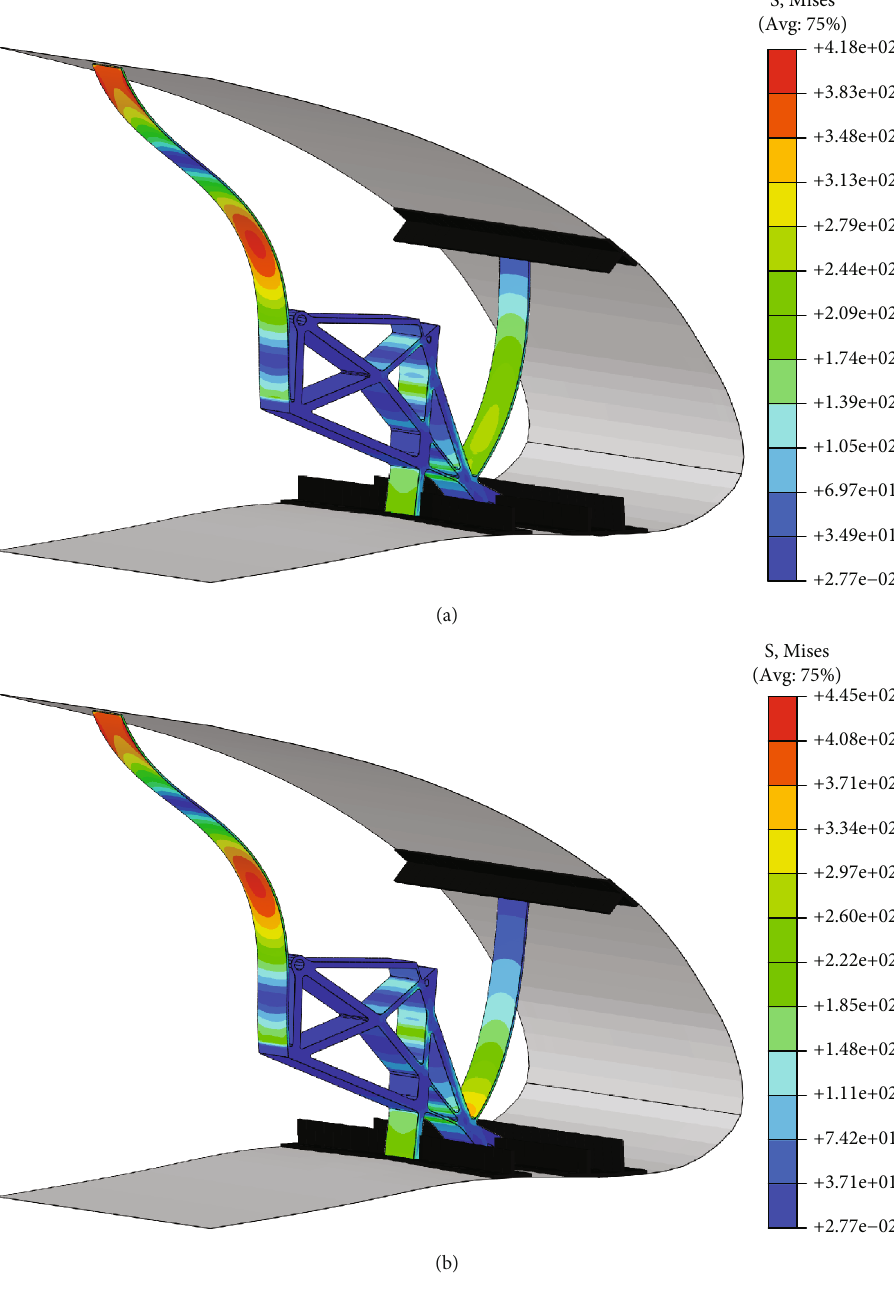
Figure 14: Stress in the tip rib. (a) Limit loads. (b) Ultimate